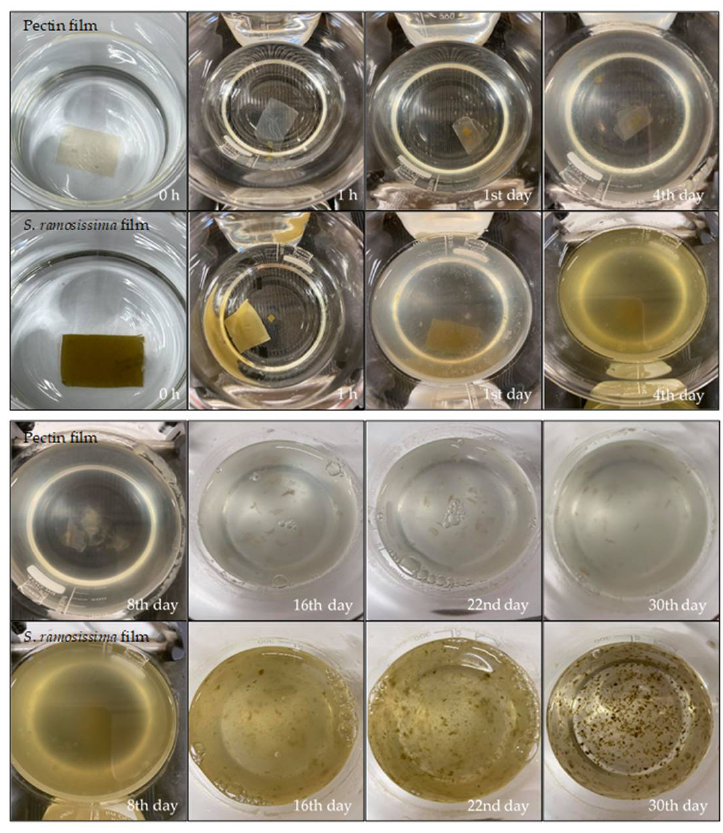
Figure 4. Biodegradation test in seawater.